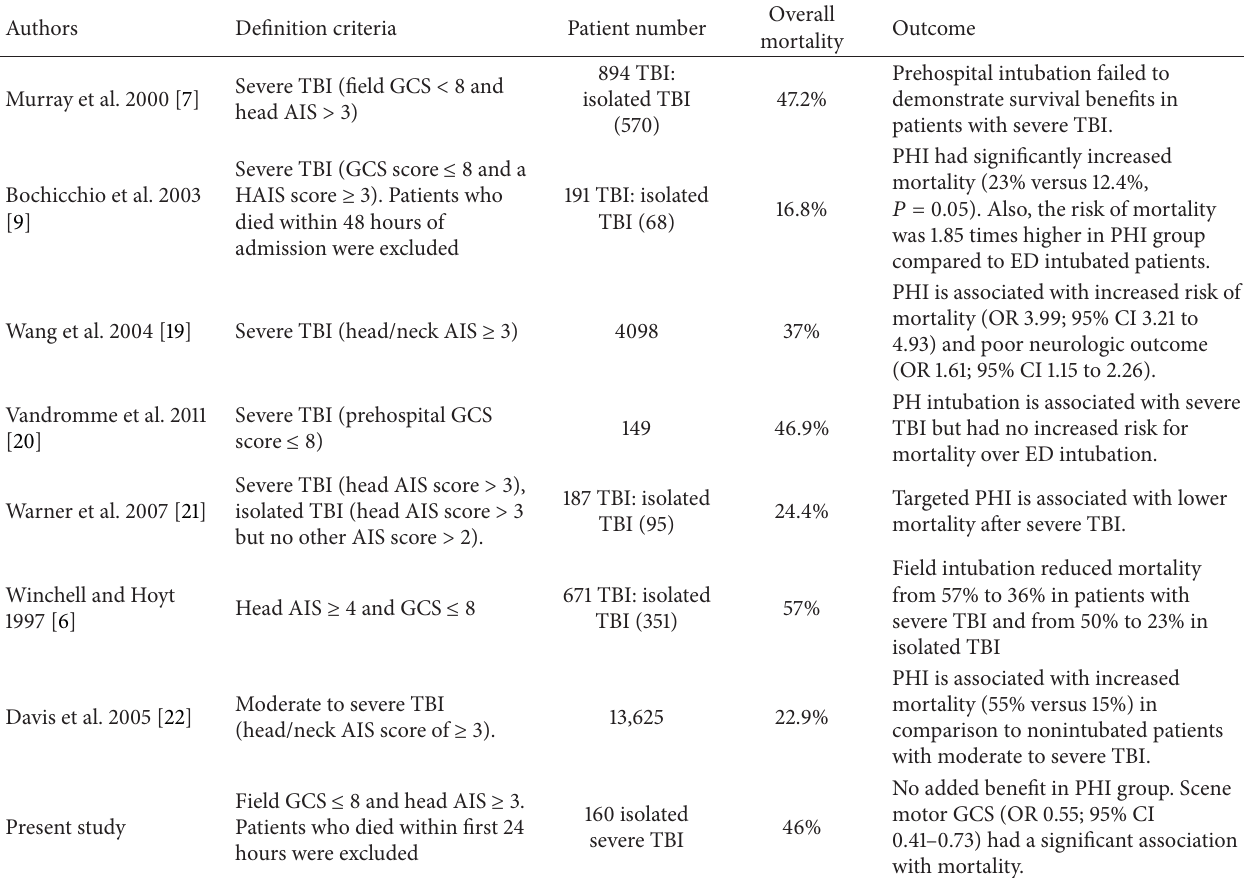
Table 3: Review of literature for prehospital intubation studies in severe TBI